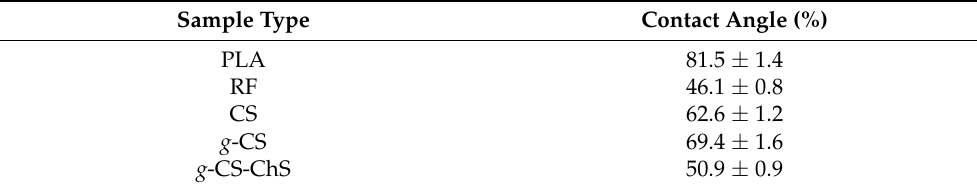
Figure 2. SEM images of the ( a ) untreated PLA; ( b ) plasma treated PLA; ( c ) CS; ( d ) CS-ChS grafted films. Table 1. Values for water contact angle for the prepared